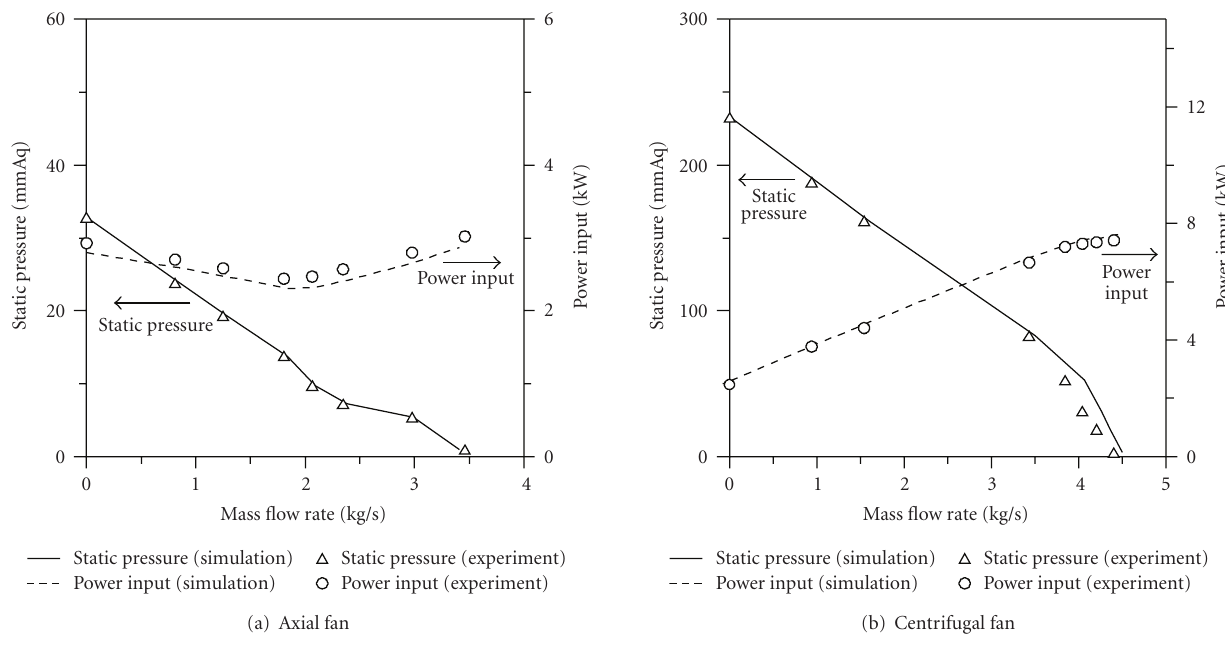
Figure 4: Performance curves for (a) axial fan and (b) centrifugal